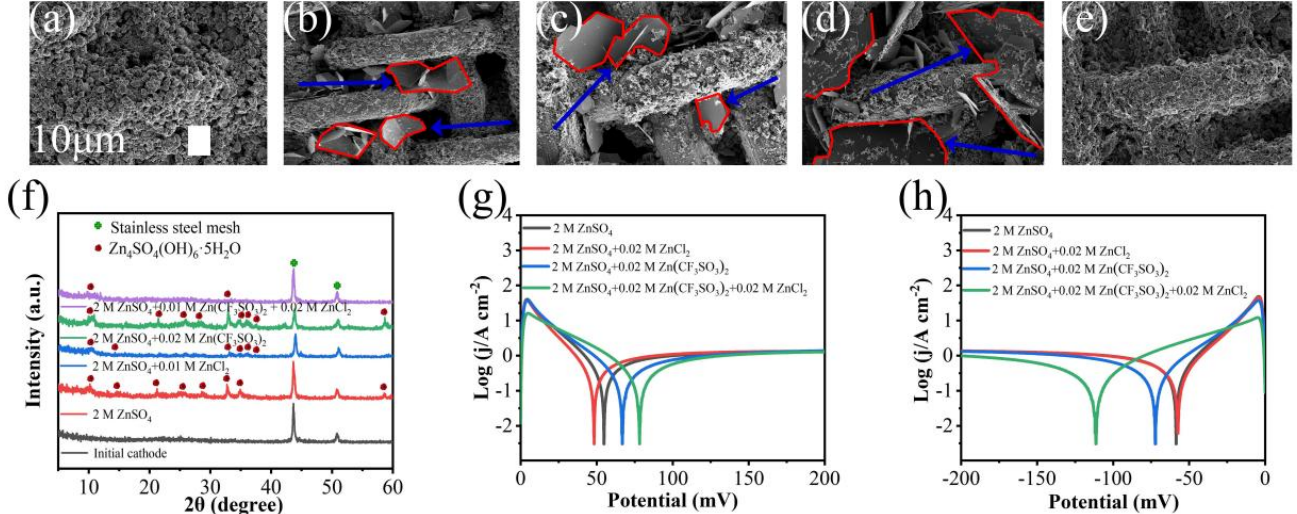
Figure 3. ( a ) AC cathode; ( b ) AC cathode in ZnSO 4 electrolyte; ( c ) AC cathode in ZnSO 4 + ZnCl 2 elec- trolyte; ( d ) AC cathode in ZnSO 4 + Zn(CF 3 SO 3 ) 2 electrolyte; ( e ) AC cathode in ZnSO 4 + Zn(CF 3 SO 3 ) 2 + ZnCl 2 electrolyte; ( f ) XRD patterns of 5 AC cathodes; ( g ) AC cathode charge state overpotential; ( h ) AC cathode discharge state overpotential.